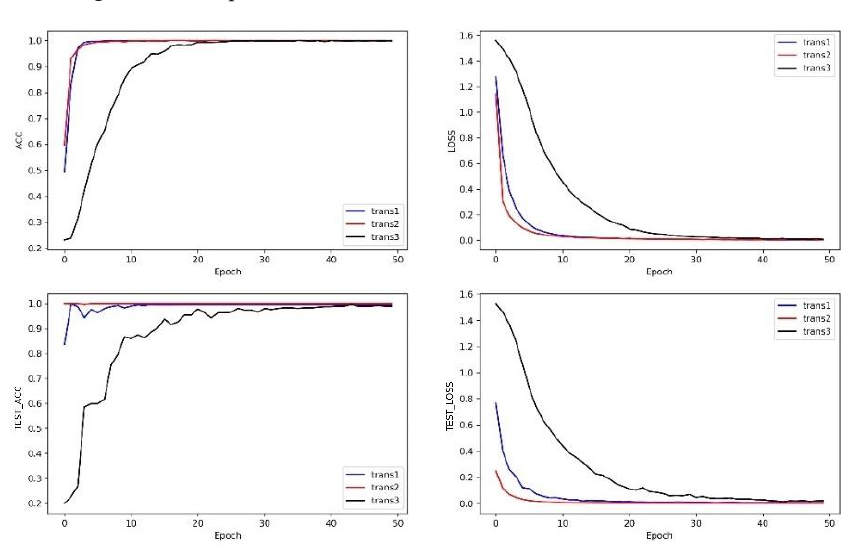
Figure 14. Comparison of three transfer methods under 0.875 data size.